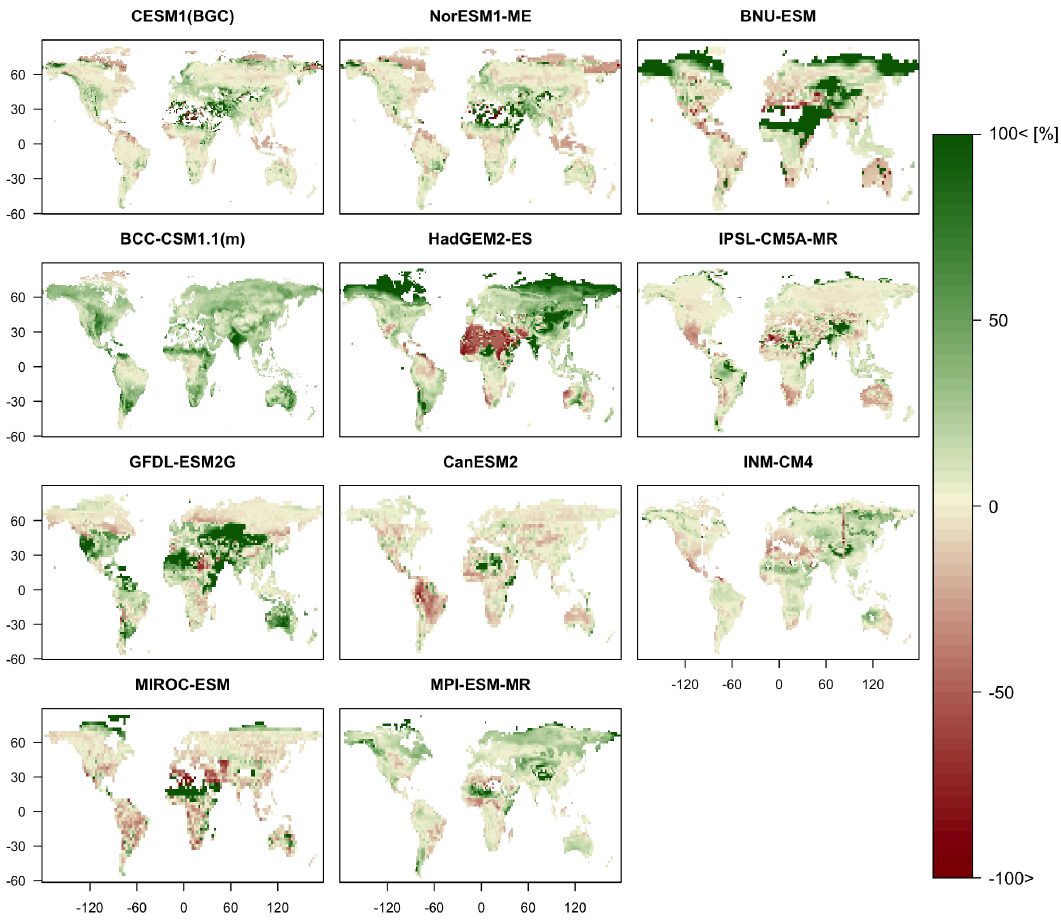
Fig. 3. Relative change in soil carbon density (%) over the 21st century for all models (difference in 10-year means divided by modern soil carbon density; 2090–2099 minus 1997–2006 divided by